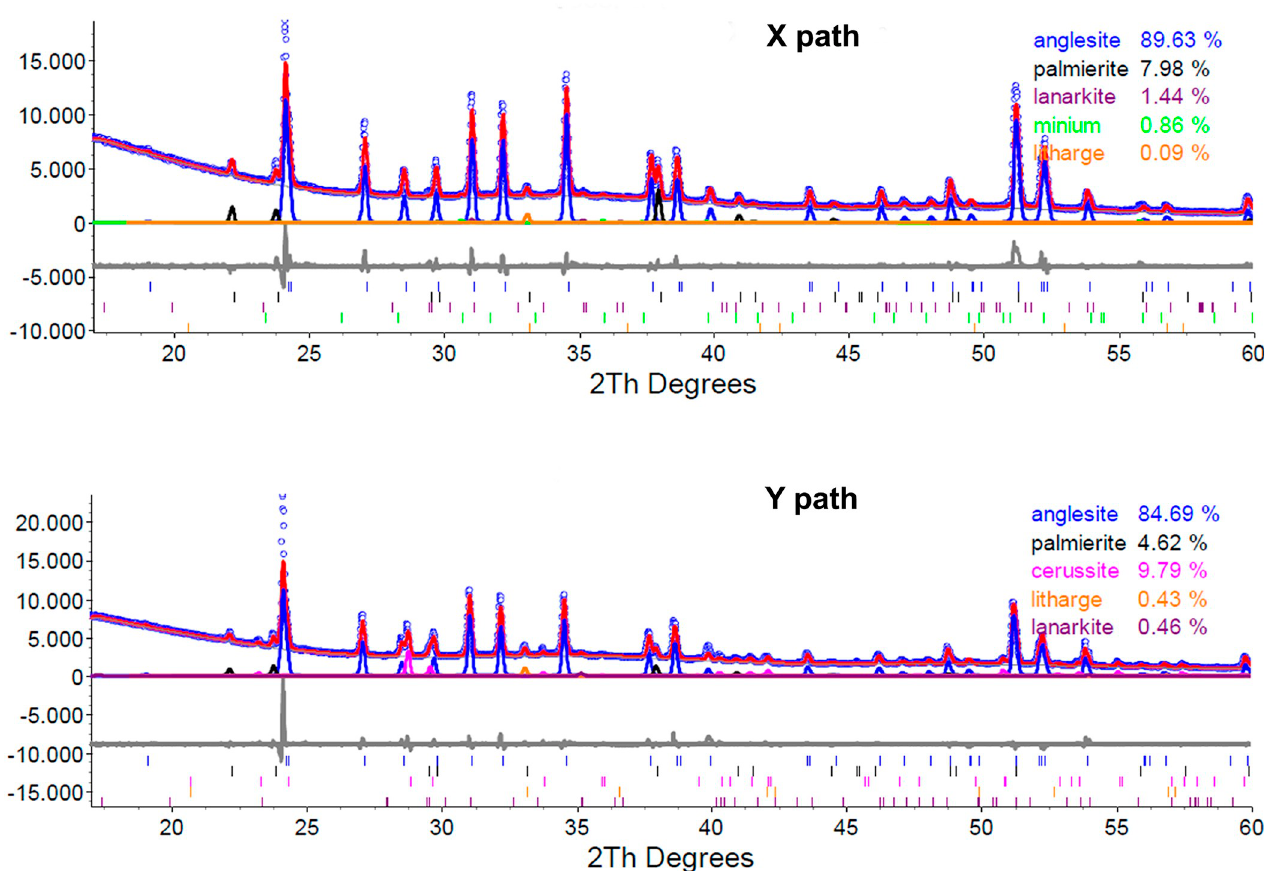
Fig 13. Diffraction patterns of the leaded lump Bleje ş ti 1–2 (S. Rovira).